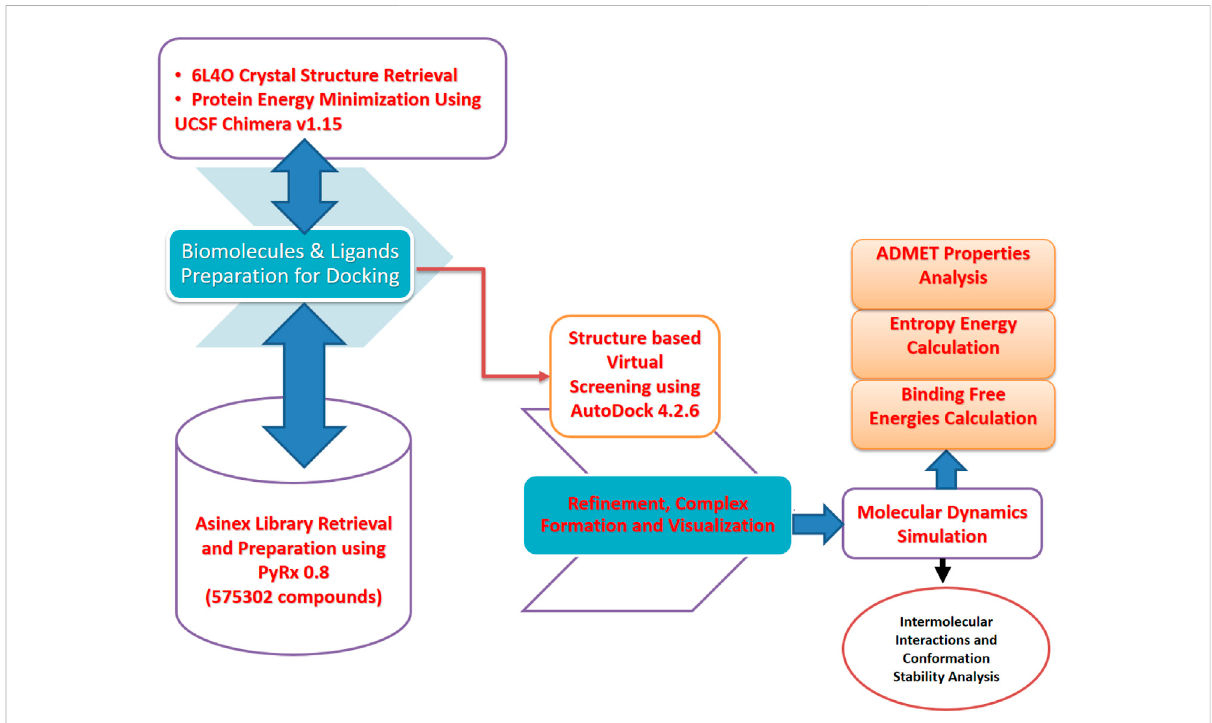
FIGURE 1 Schematicpresentationofthemethod fl owutilizedinthisstudy.Thestudywasdividedintoseveralphasesrangingfromthebiomolecule(FGF2) and inhibitor library retrieval to virtual screening, molecular dynamics simulation, and binding free energy